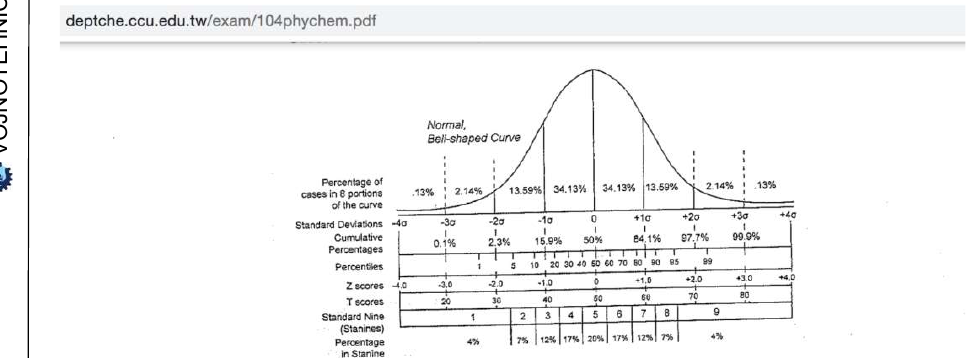
Figure 3 – Fig. 5 from Kočović et